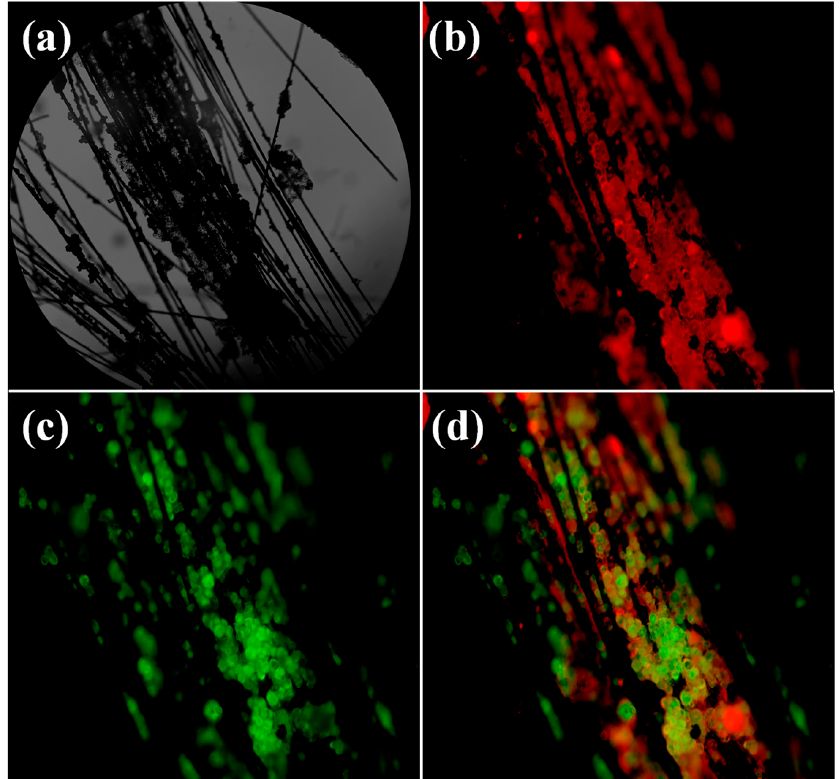
Figure 4. Distribution of double enzymes in g-C 3 N 4 /CF composite carrier. ( a ) Bright field image; ( b ) distribution of Rhoda mine B labeled lactase on g-C 3 N 4 /CF composite carrier; ( c ) distribution of FITC-labeled glucose isomerase on g-C 3 N 4 /CF composite carrier; ( d ) the distribution of lactase and glucose isomerase on g-C 3 N 4 /CF composite carrier. Herein, the g-C 3 N 4 /CF referred to the g-C 3 N 4 /CF composite carriers synthesized by being calcined with melamine and CF in 550 °C for 3 h.